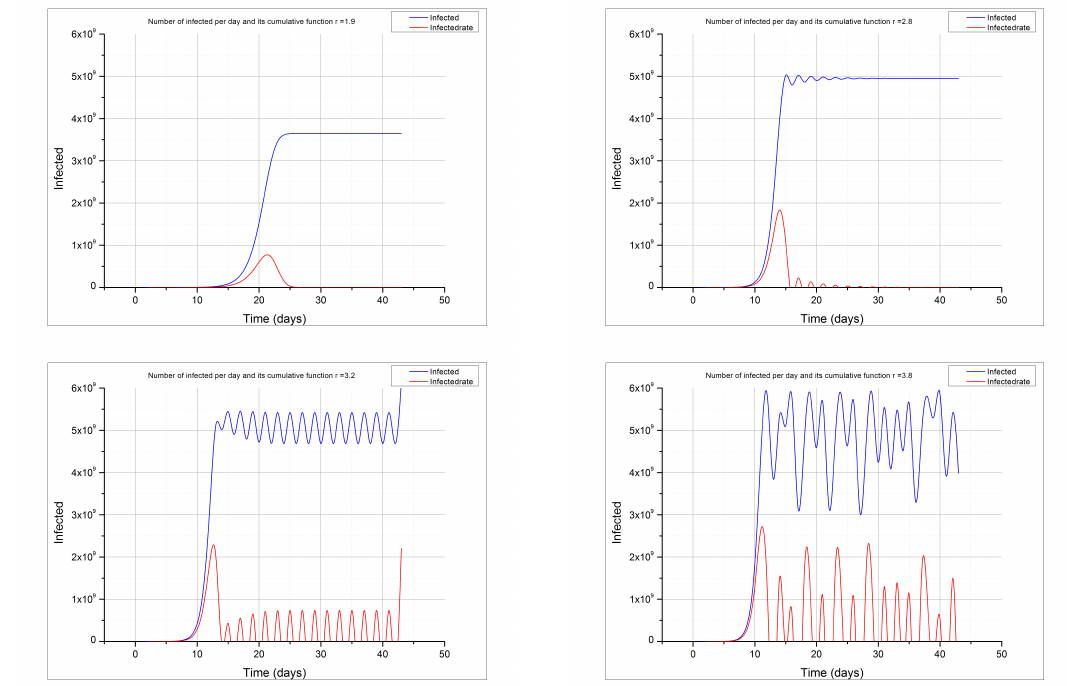
Figure 3. Number of infected obtained for the logistic map as a function of r for the different options, from r = 1.9 to r =